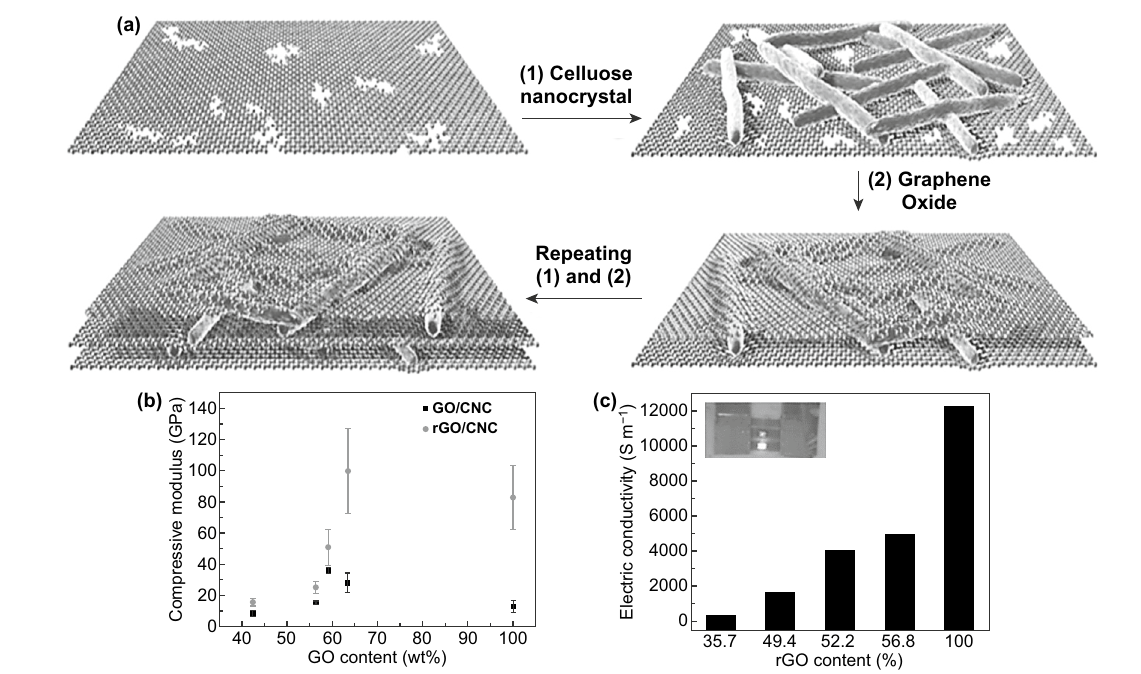
Fig. 16 a Cyclical process of CNCs and GO multilayer assembly strategy. b Micromechanical properties of CNCs-GO and CNCs-rGO films with different GO content. c rGO content impact in electrical conductivity. Reproduced with permission from Ref. [106] Copyright © 2015, WILEY ‐ VCH Verlag GmbH & Co. KGaA, Weinheim